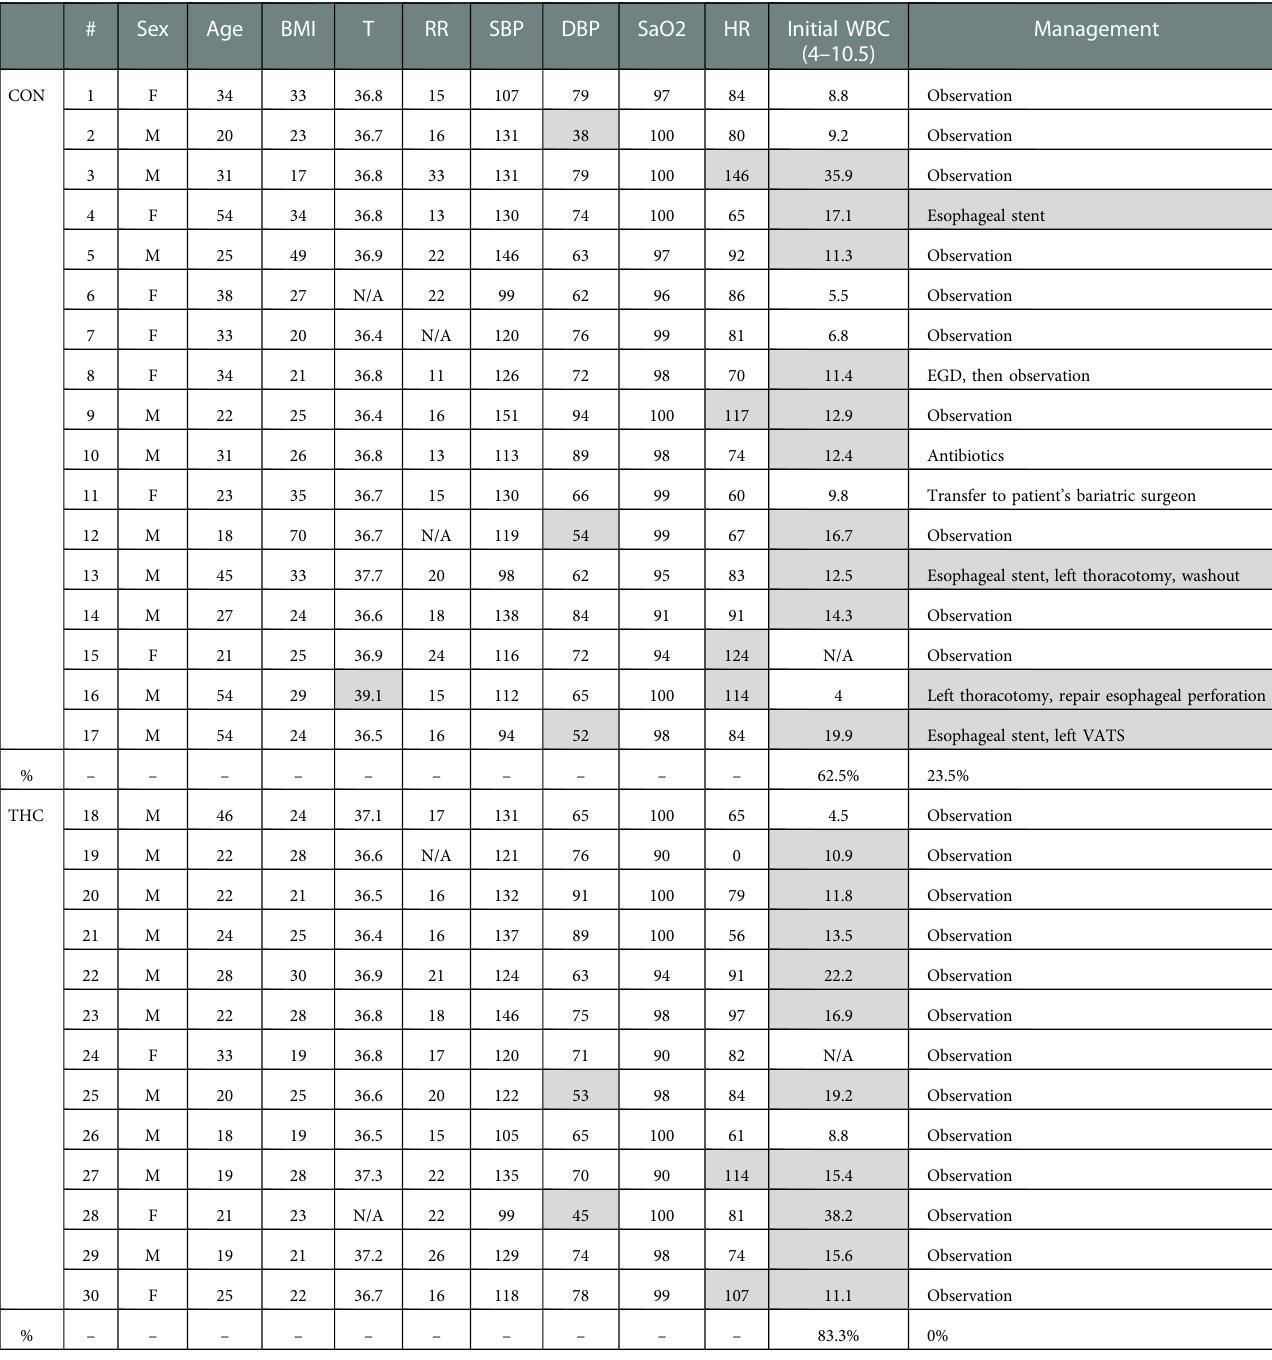
TABLE 3 Presenting vital signs and presenting white blood cell